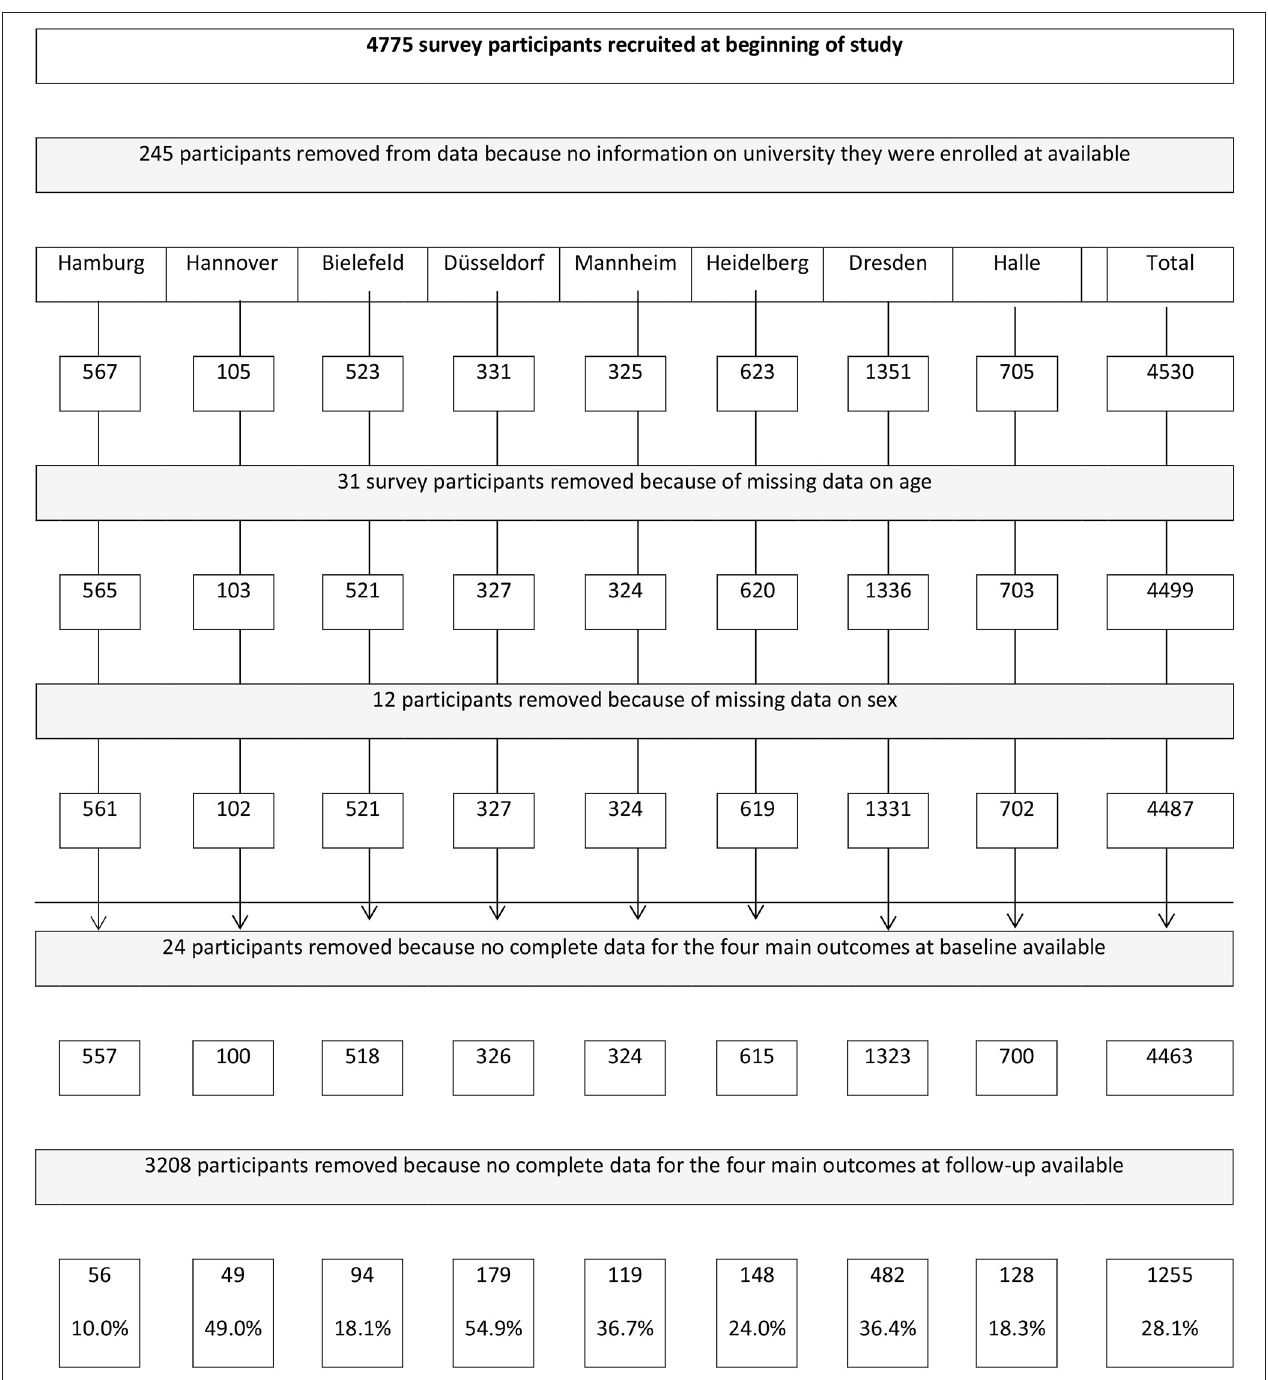
FIGURE 1 | Flow chart of participants through the trial and analyses.